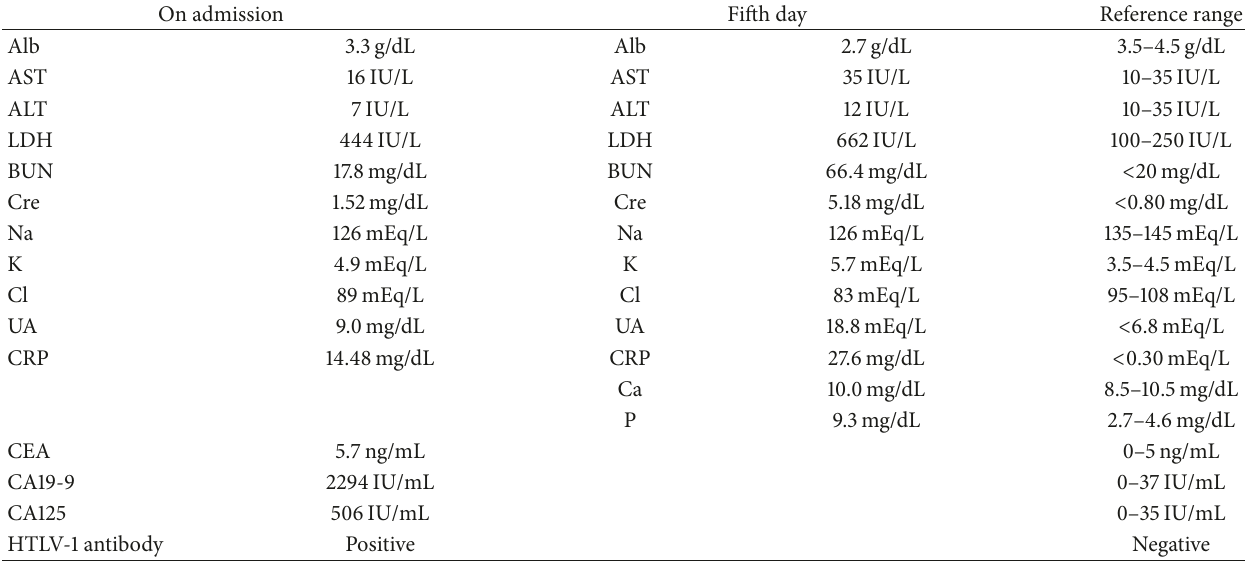
Table 1: Laboratory tests upon admission.